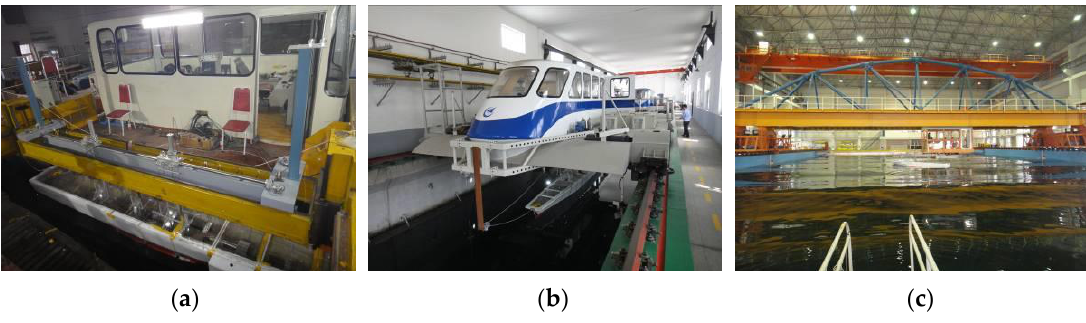
Figure 9. Towing tank facilities: ( a ) towing tank; ( b ) high speed tank; and ( c ) deep ocean basin. Table 3. Technique data of the tank facilities.